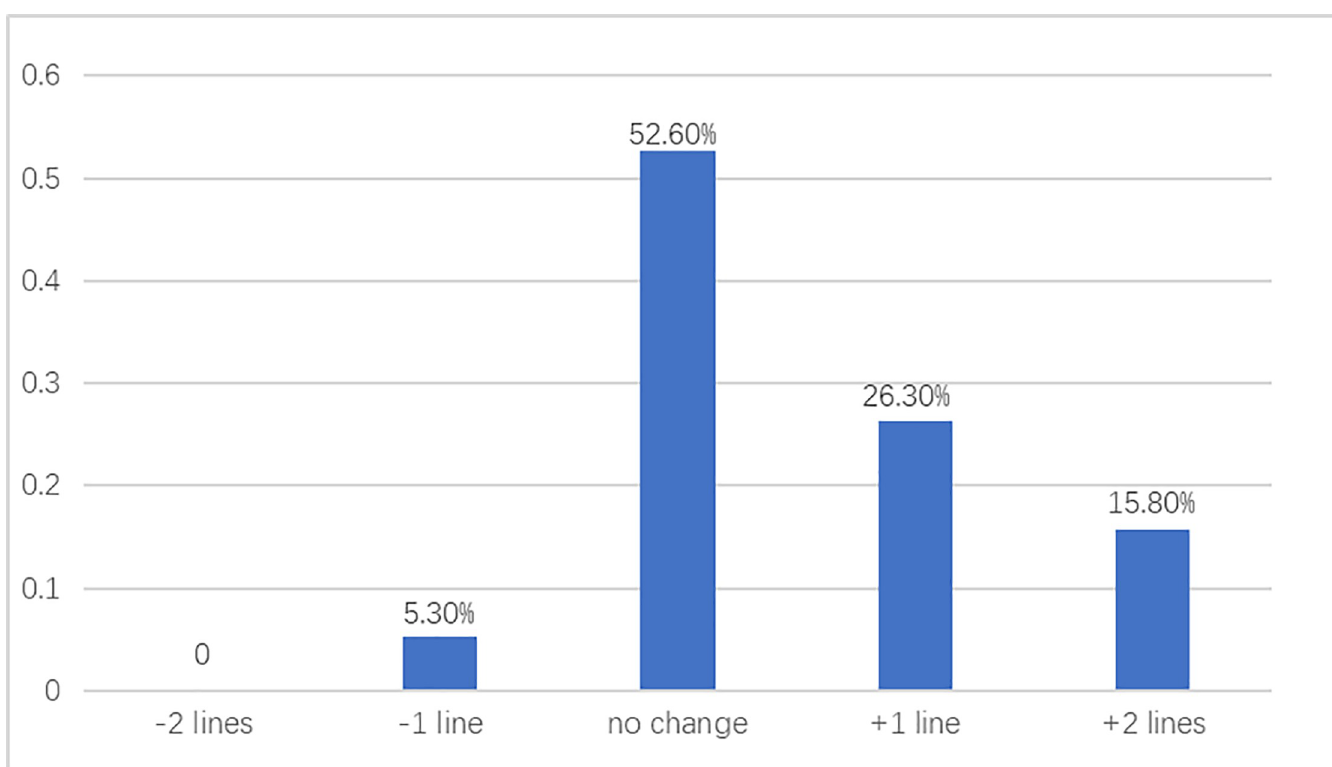
Fig 1. The change of CDVA before and one year after surgery.